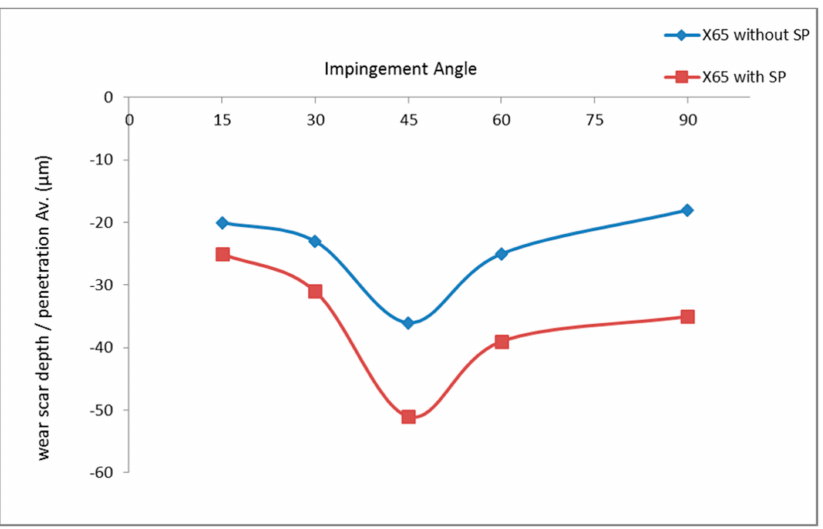
Figure 9. Variation of wear scar penetration depth ( µ m) during corrosion and erosion corrosion experiments at different angles.